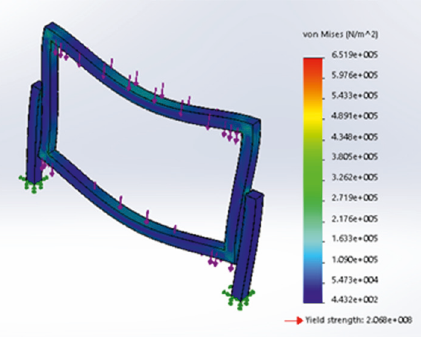
Figure 6: Prototype for fixture scale-down design.